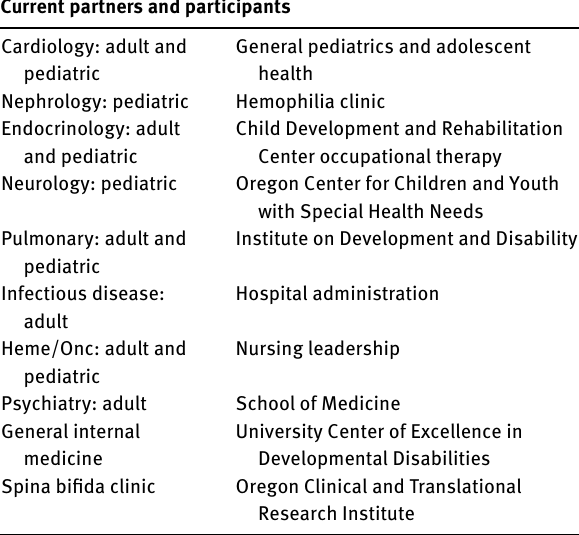
Table 1: Current departments and divisions represented among Transition Task Force